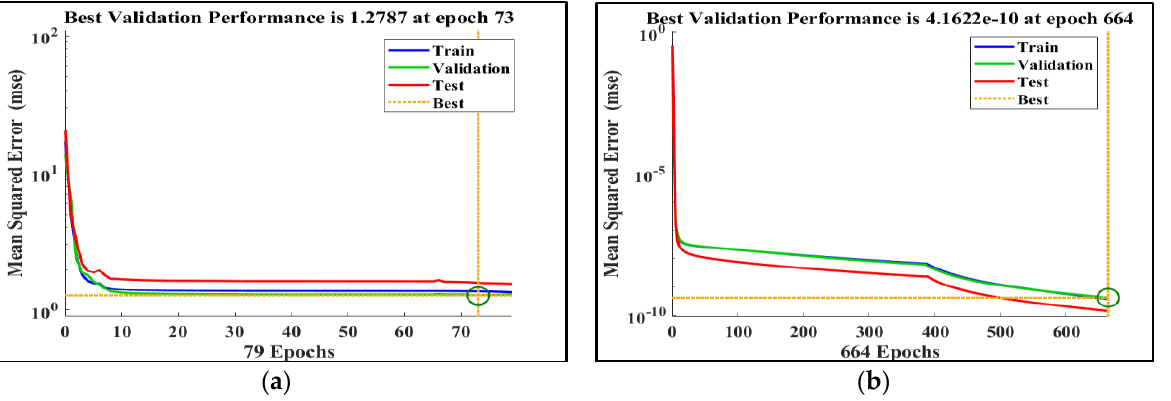
Figure 24. The evolution of training, validation, and test errors for ( a ) fault classification and detection and ( b ) fault location.